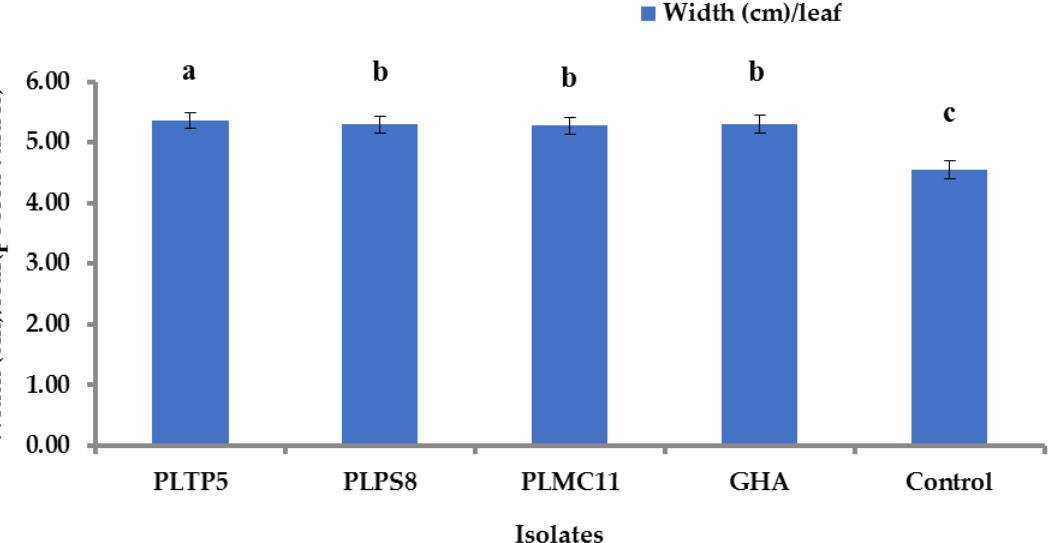
Figure 10. Effect of EPF conidia formulation application on the leaf width of sugarcane. Different letters (a–c) in columns indicate significant differences ( p ≤ 0.05) among the isolates. Columns represent the mean ± SD ( n = 3). SD = standard deviation.